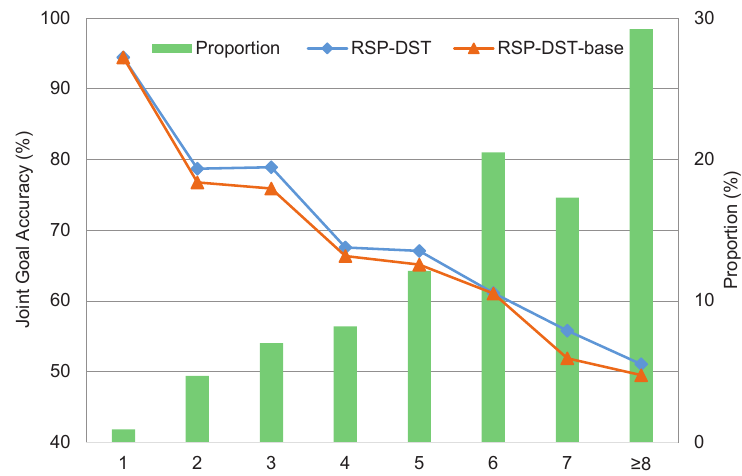
Figure 7. Joint goal accuracy at each turn on the test set of MultiWOZ